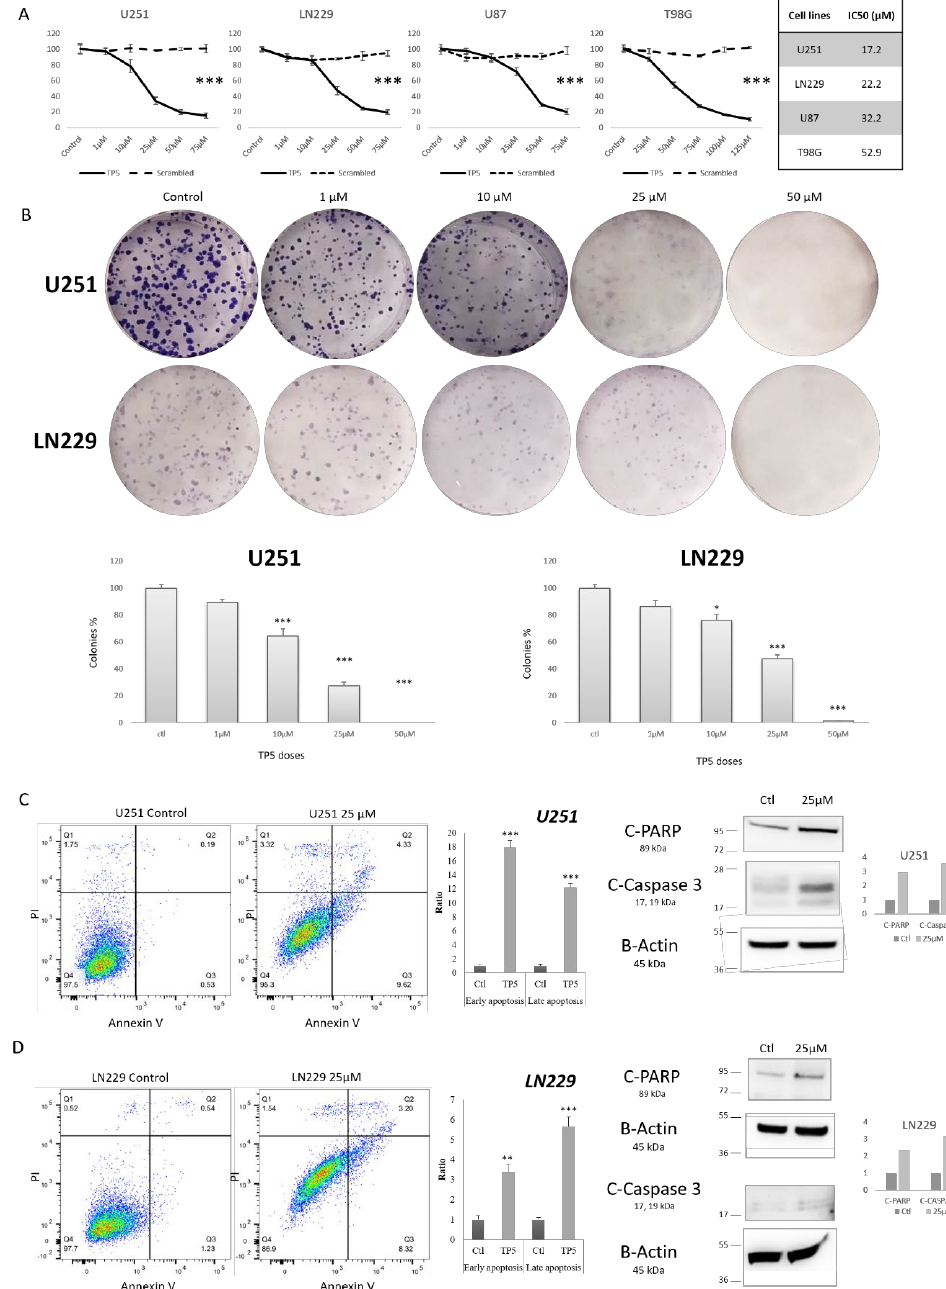
Figure 2. TP5 decreases cell viability by inducing cell apoptosis. ( A ) Viability of U251, LN229, U87 and T98G cells treated by indicated concentrations of TP5 or scrambled peptide for 72 h is shown (*** p > 0.001). Right table: IC50 concentrations. ( B ) Clonogenic growth of U251 (top panels) and LN229 (bottom panels) cells is shown. The bar graphs display quantification of colonies under treatment at indicated concentrations ( N = 3). (* p < 0.05; *** p < 0.001). ( C ) Apoptosis analysis by Annexin V / Propidium Iodide (PI) staining. Left panel: representative flow cytometry dot plot graphs of annexin V and PI in U251 cells are shown. The bar graph displays the quantification of early (Q3) and late (Q2) apoptotic cells after treatment by TP5 (25 µ M) in U251 cells ( N = 4) (*** p < 0.001). Right panel shows protein level of cleaved PARP and cleaved Caspase 3 in U251 cells after 24 h of treatment by TP5 (25 µ M). ( D ) Apoptosis analysis in LN229 cells. Left panel: representative flow cytometry dot plot graphs of annexin V and PI in LN229 cells are shown. The bar graph displays the quantification of early and late apoptotic cells after treatment by TP5 (25 µ M) in LN229 cells ( N = 4; ** p < 0.01; *** p < 0.001). Right panel shows protein level of cleaved PARP and cleaved Caspase 3 in LN229 cells after 24 h of treatment by TP5 (25 µ